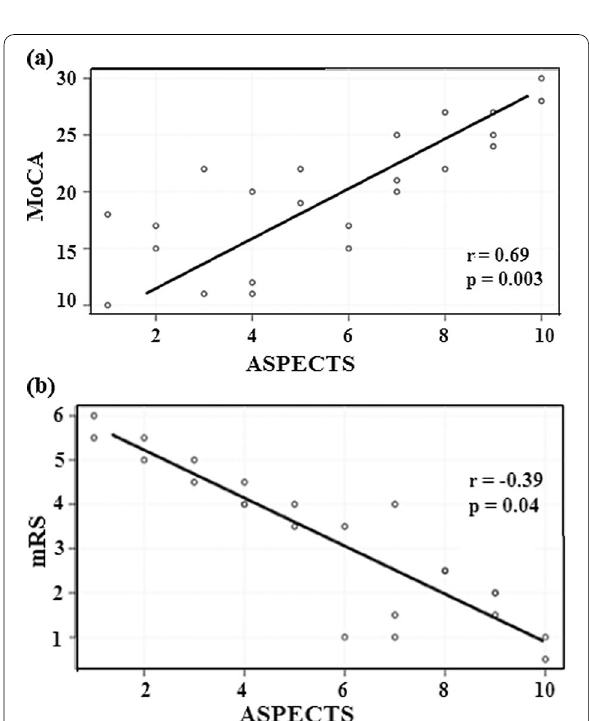
Fig. 2 a Correlation of ASPECTS and MoCA. b Correlation of ASPECTS and mRS